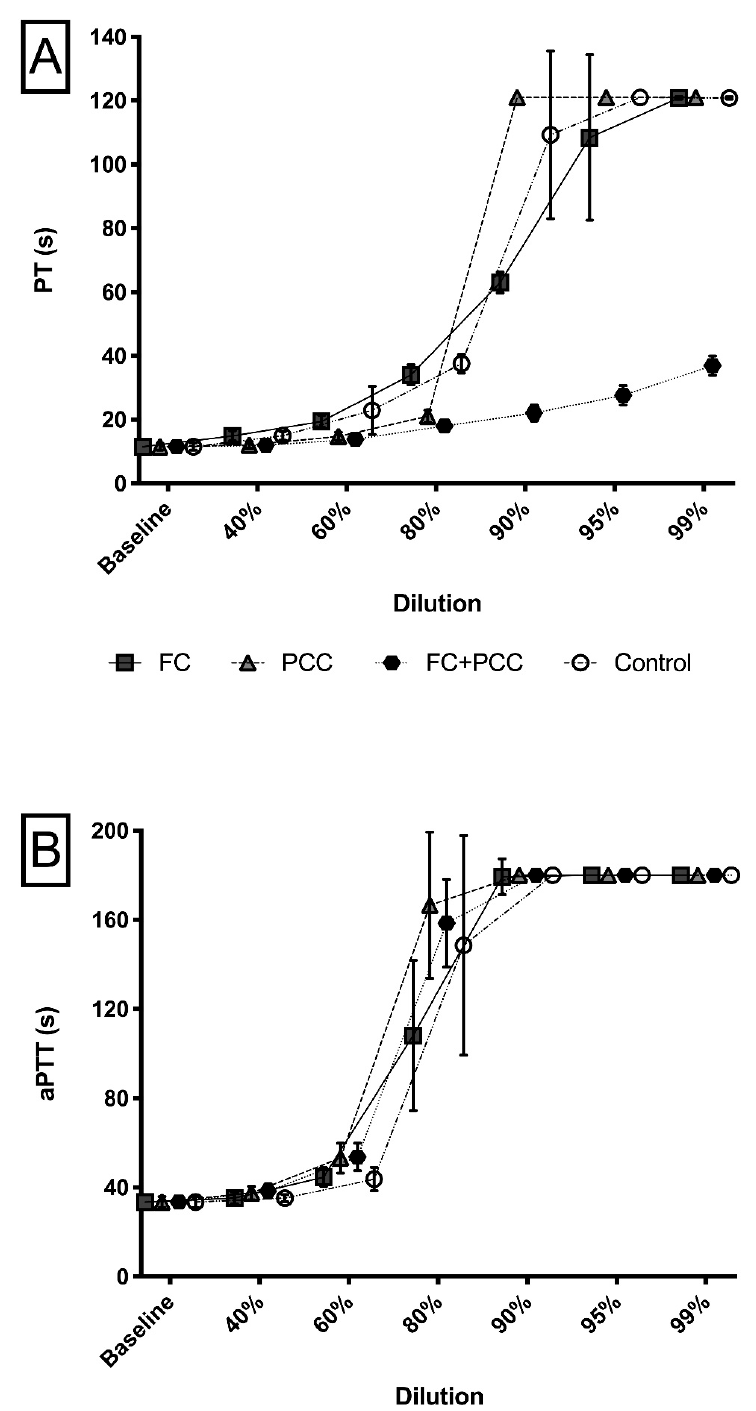
Figure 2. ( A ) Prothrombin time and ( B ) activated partial thromboplastin time in a comparison between the four study groups and different dilution levels. ( A ) Significant differences ( p < 0.05) occurred at the 60% and 80% dilution levels between the groups containing PCC (PCC, FC+PCC) and those that did not (FC, Control), whereas, at the 95% and 99% dilution levels, only the FC+PCC group showed significantly different results in comparison to all other groups. ( B ) Significant intergroup differences ( p < 0.05) occurred at the 80% dilution level only. PT, prothrombin time; aPTT, activated partial thromboplastin time; FC, fibrinogen concentrate group; PCC, prothrombin complex concentrate group; FC+PCC, combined fibrinogen and prothrombin complex concentrate group; Control, control group.